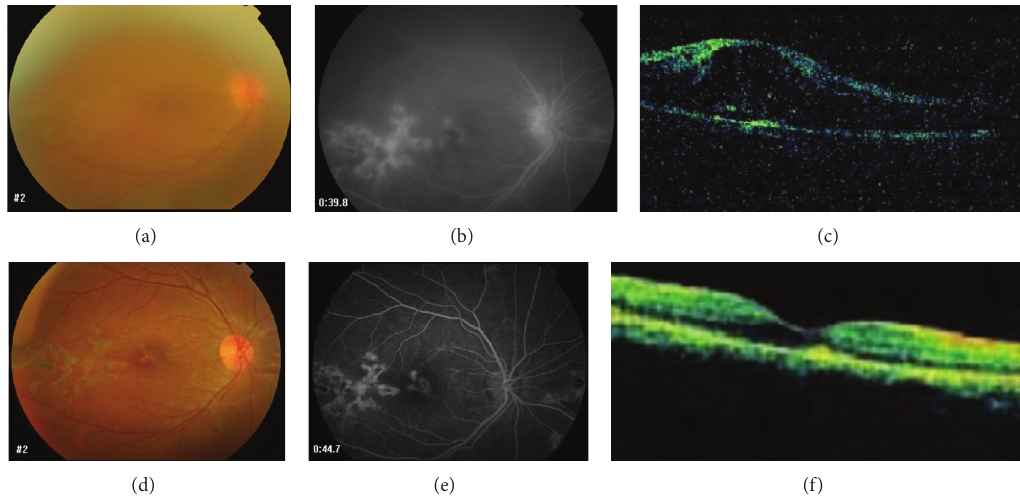
Figure 2: A 28-year-old female with presumed intraocular tuberculosis, choroiditis, and cystoid macular edema in the right eye. (a), (b), and (c) are the fundus photos, fluorescein angiograms, and optical coherence tomographies, prior to treatment with intravitreal bevacizumab. (d), (e), and (f) are the fundus photos, fluorescein angiograms, and optical coherence tomography, after treatment with intravitreal bevacizumab, which shows good response. Table 1: Demographics, visual acuity, and macular thickness of patients with uveitic cystoid macular edema treated with intravitreal bevacizumab. IIU BD IPU POTBU 𝑃